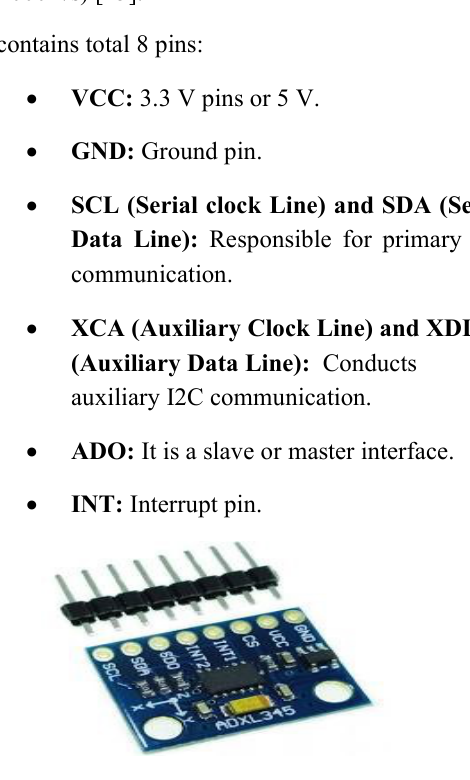
Figure 3. GY-521